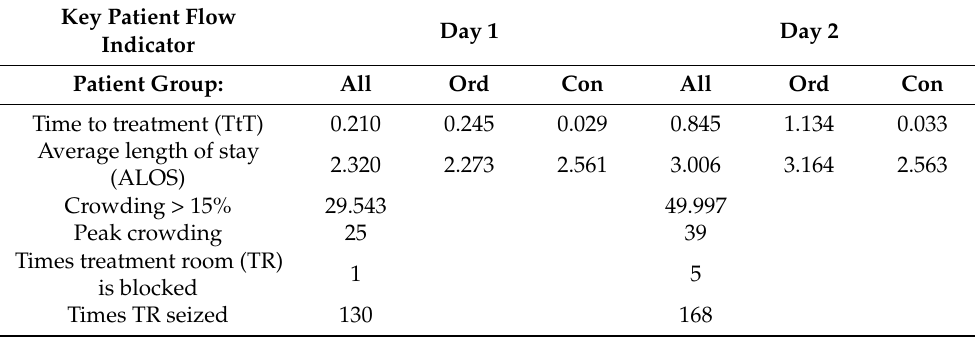
Table 13. Table displaying a subset selection of KPI from Sc.5. Key Patient Flow Indicator